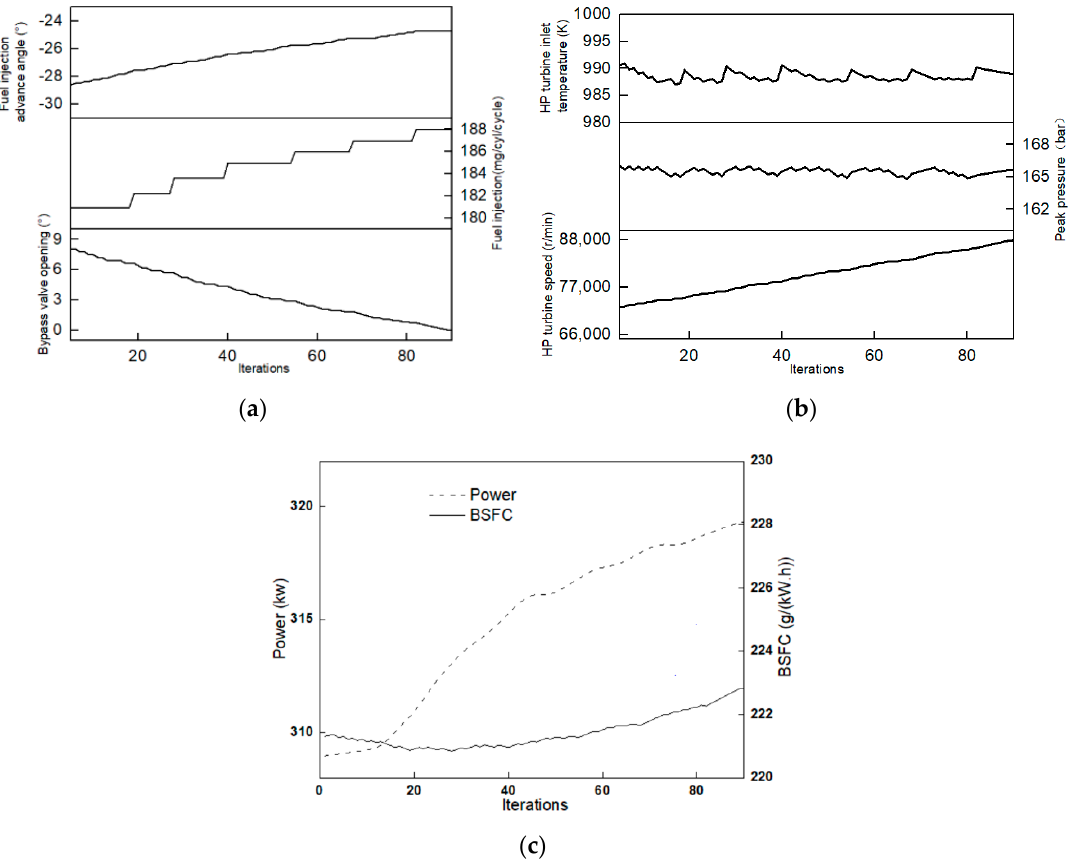
Figure 9. Optimization process at full load point of 2100 r / min. ( a ) Optimization parameters; ( b ) Boundaries; ( c ) Engine Power and BSFC.